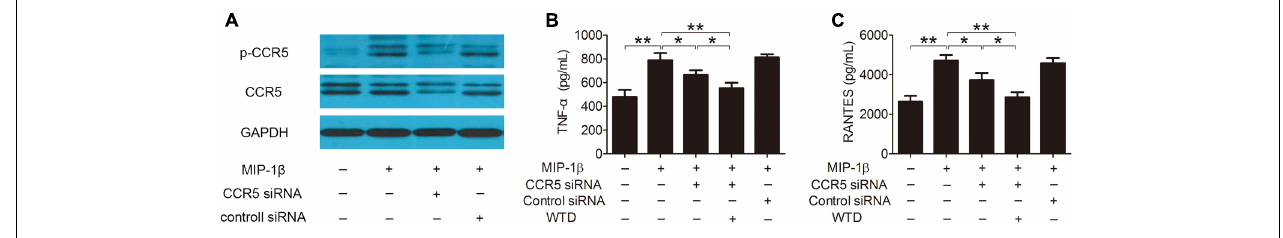
FIGURE 4 | Effects of WTD on production of TNF- α and RANTES in MIP-1 β -induced U937 cells after CCR5 knockdown. U937 cells were transfected with or without CCR5 siRNA, then treated with or without WTD for 2 h, and then exposed to MIP-1 β (25 nM) for 24 h. Total CCR5 and its phosphorylation form (A) were detected by western blotting. The levels of TNF- α (B) and RANTES (C) in cell supernatants were detected by ELISA. ∗∗ P < 0.01, ∗ P <